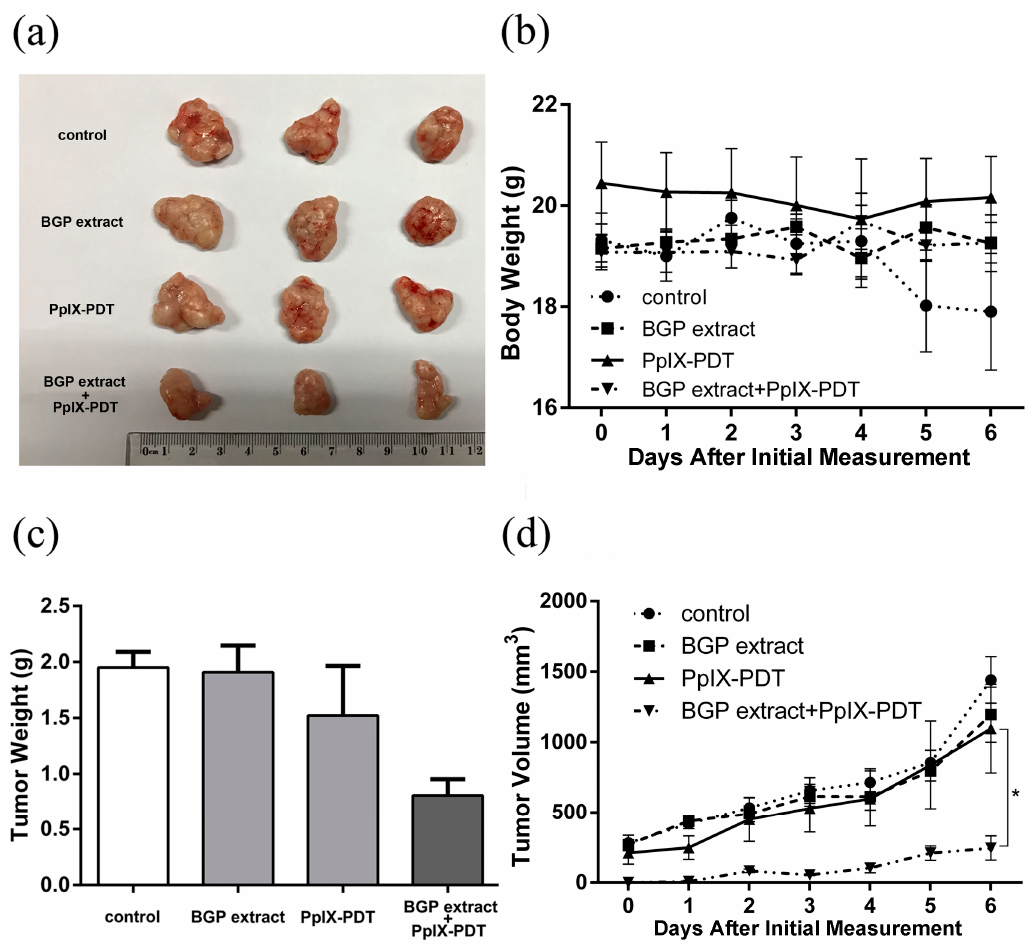
Figure 6. Brazilian green propolis (BGP) extract enhanced the anti-tumorigenicity of protoporphyrin IX-mediated photodynamic therapy (PpIX-PDT) in a BALB/c-nu mice xenograft model. A total of 3 × 10 6 A431 cells, pretreated with BGP extract (75 μ g/mL) and PpIX-PDT (2.7 μ M), either alone or in combination, were implanted subcutaneously into BALB/c-nu mice (6 per group). All groups were illuminated by laser. ( a ) The representative images of tumors after two-week development; ( b , d ) Body weight and tumor volume (* p < 0.05) of mice were measured once per day after one-week development; ( c ) Mice were sacrificed 2 weeks after implantation and tumor weight was measured.